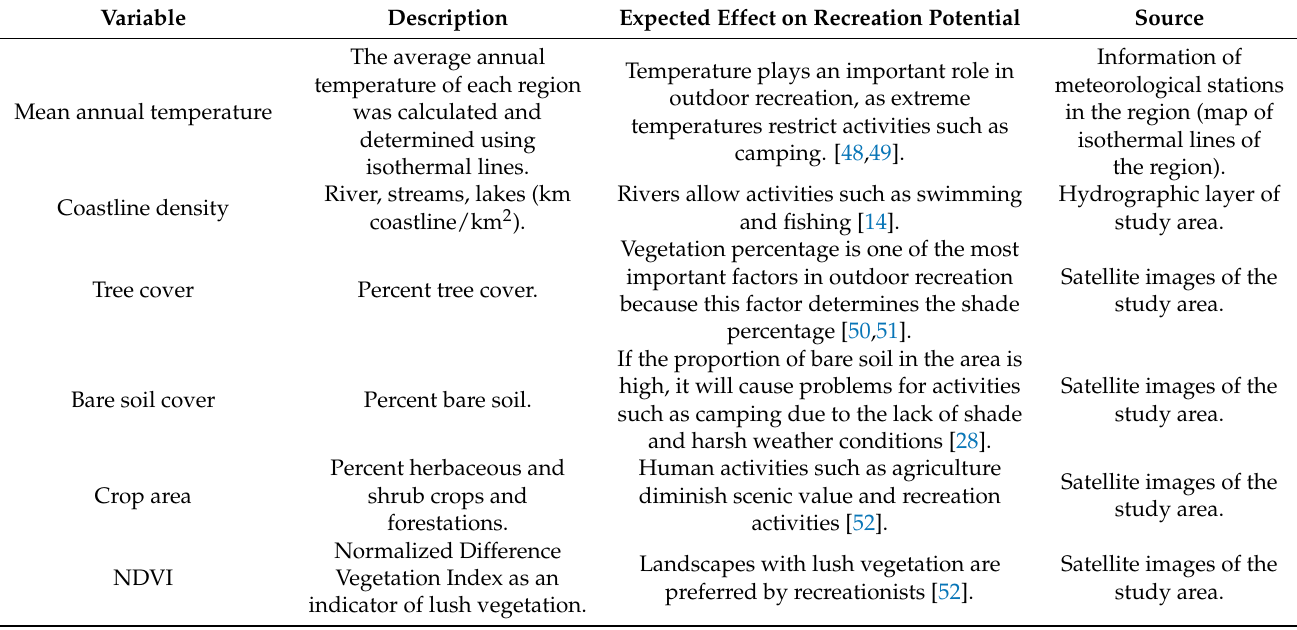
Table 5. Landscape metrics (variables) used as indicators of outdoor recreation potential